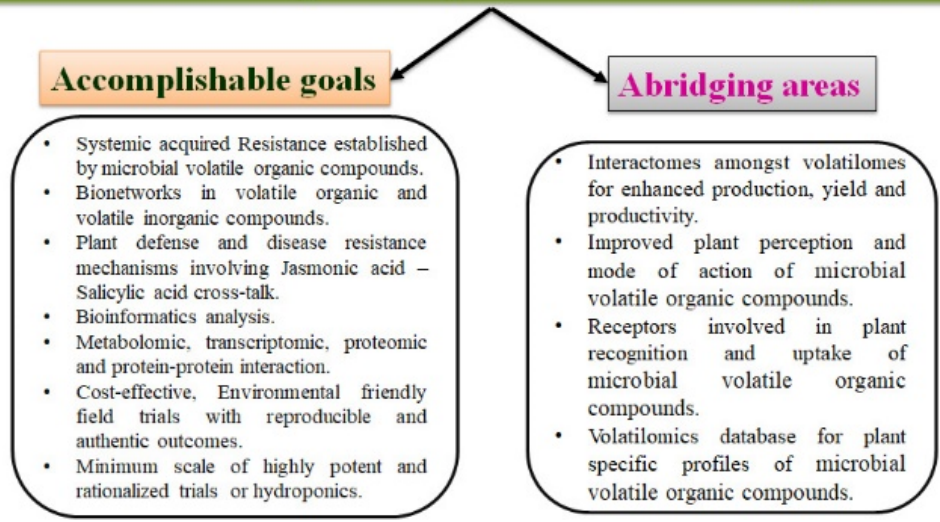
Figure 2. Goals and abridging areas of sustainable agriculture.